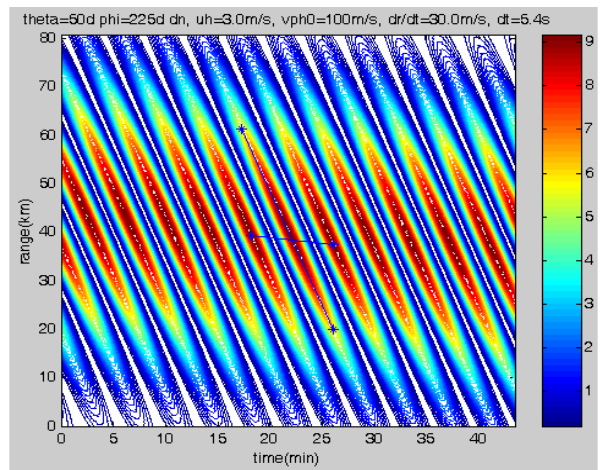
Fig. 3. Same as Fig. 2, except that the preset parameters were: Fig. 2. RTI plot of the numerical gravity wave packet gener- τ 0 = 7 . 5 min, v ph 0 = 20m/s, τ b = 5 . 0 min, u h = 1.0m/s, H = 8km, ated by Eq. (13) with following preset parameters: τ 0 = 7 . 5 min, θ = 50 ◦ , and φ = 45 ◦ . The result of the measurements: τ = 7 . 64 min, v ph 0 = 100m/s, τ b = 5 . 0 min, u h = 3m/s, H = 8km, θ = 50 ◦ , and Fig.2 RTI plot of the numerical gravity wave packet generated by equation (11) = τ Fig.3 Same as Fig.2 except the preset parameters were: min5.7 v pr =− 83.8m/s, v gr =+ 13.8m/s. And the theoretical prediction: φ = 225 ◦ . The slope of the phase line along the central patch 0 τ = 7 . 5 min, v pr =− 82.8m/s, v gr =+ 12.7m/s. is equal to the characteristic radial phase velocity v pr ; the with following preset parameters: min5.7 =τ 0 slope of the energy line across the neighboring patches is equal to the radial group velocity v gr ; the horizontal distance be- tween two neighboring patches is equal to one-half of the wave period τ . The result of the measurements: τ = 7 . 45 min, v pr =− 78.5m/s, v gr =− 4.01m/s. The theoretical prediction: (cid:14) σ 0 = 7 . 5 min, v ph 0 = v px 0 = 100 m/s; the atmo- were τ 0 = 1 (cid:14) ω b = 5 . 0 min, u h =3.0 spheric parameters were τ b = 1